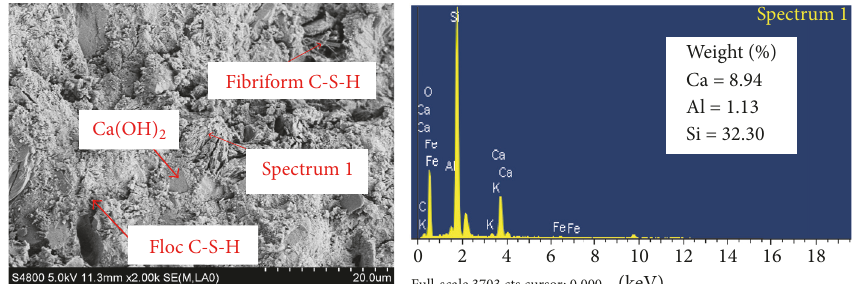
Figure 13: SEM and EDS results of OPCC in the 60-day standard curing group.